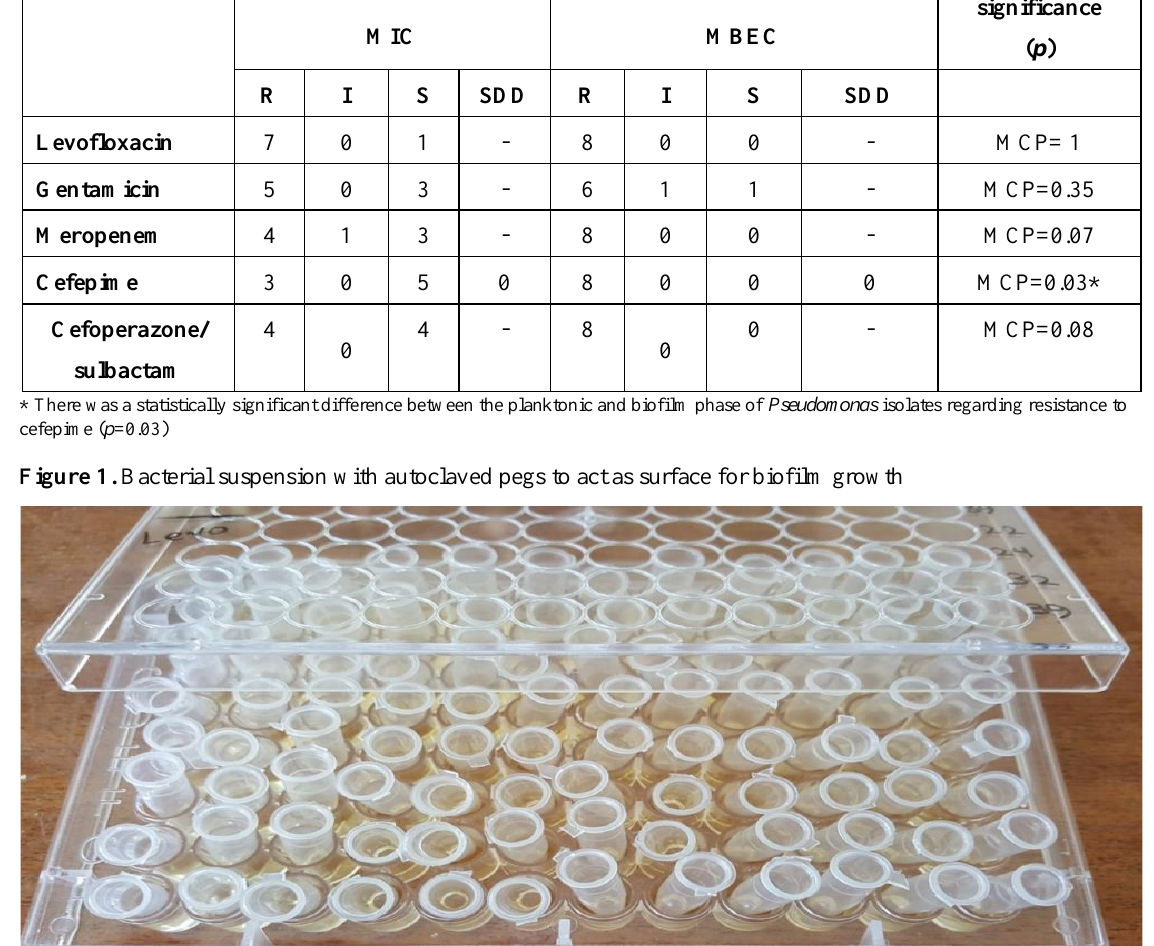
Table 5. Interpretation of MIC and MBEC results for Pseudomonas biofilm forming isolates Antibiotic